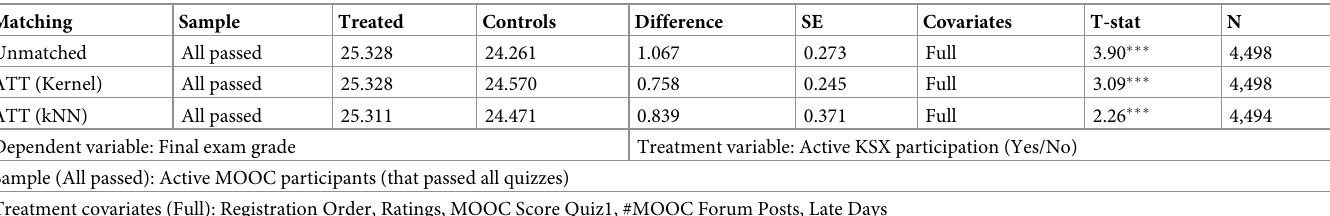
Table 7. Effect of KSX participation on MOOC final exam